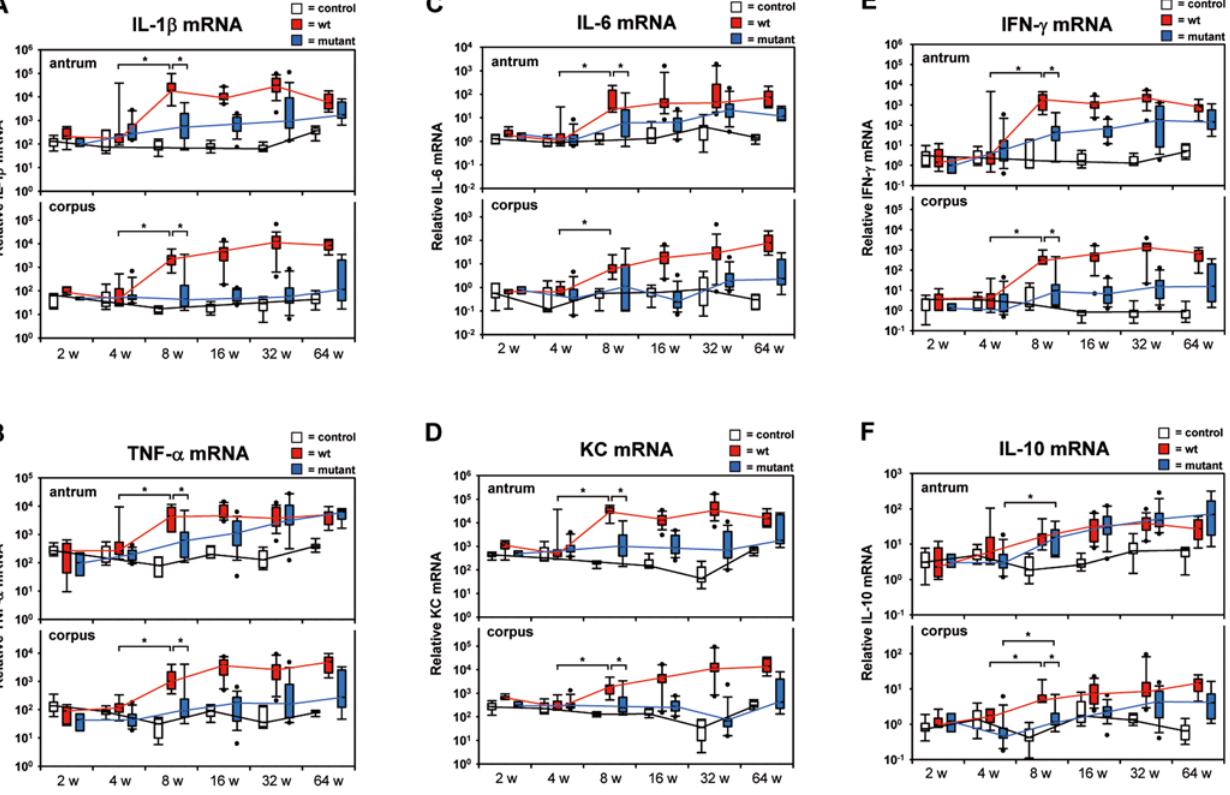
Figure 5. Early inflammatory events are reflected on mRNA level. (A) IL-1 b , (B) TNF- a , (C) IL-6, (D) KC, (E) IFN- c , and (F) IL-10 mRNA were measured by real-time RT-PCR normalized to 18S ribosomal RNA of antral and corpus mucosa of gerbils orally challenged with H. pylori B128 WT (red box) and B128 D cag Y (blue box) isogenic mutant strain for 2, 4, 8, 16, 32, and 64 weeks compared with age-matched non-infected controls (white box). All box plots show 25th to 75th percentiles (box) and 5th to 95th percentiles (whiskers). Solid dots are outliers below 5% and above 95%. The line in the box represents the median. The interpolated lines connect the medians of the respective time-points. (*p , 0.05).